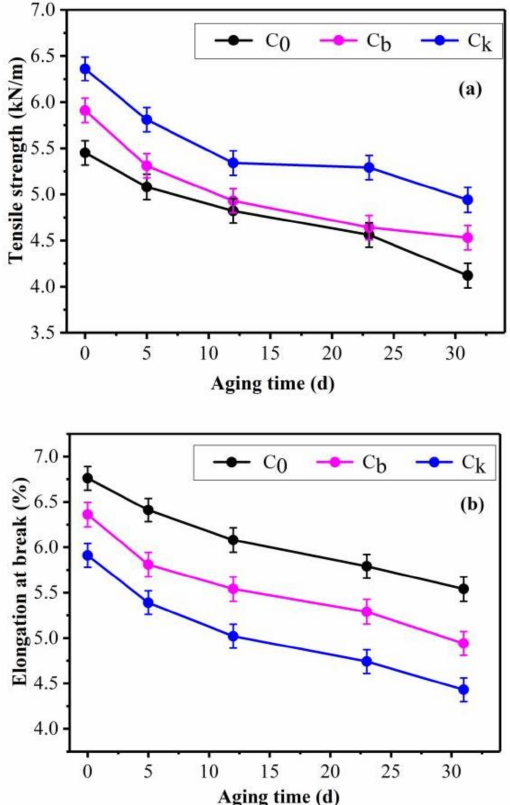
Figure 3. Tensile strength ( a ) and elongation at break ( b ) of the insulation papers with different degrees of